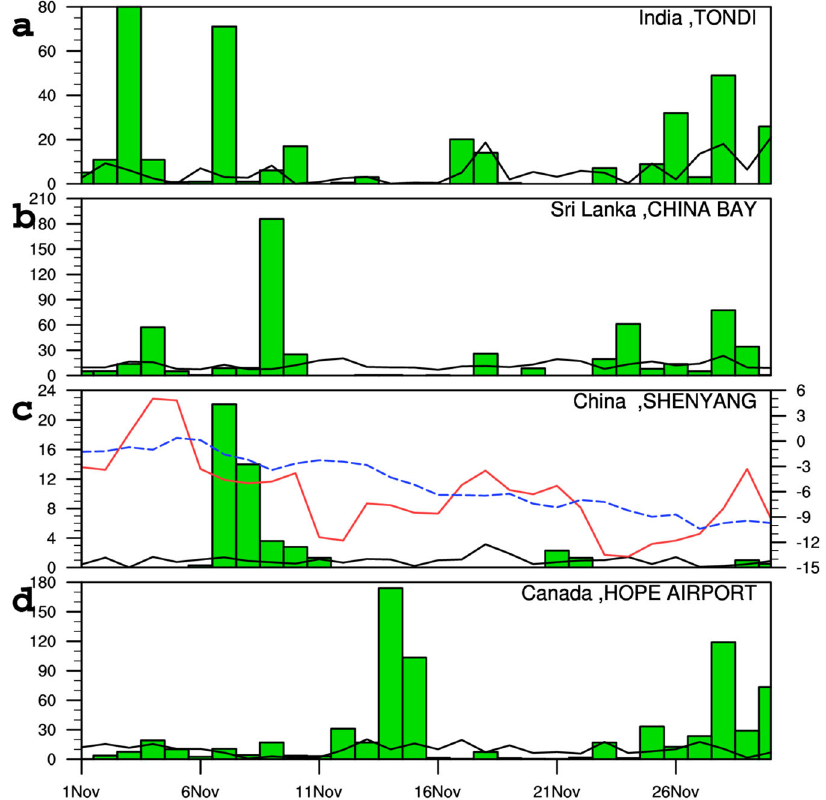
Fig. 1 Sequential extreme precipitation events from India to Canada during COP26 2021. Histograms show daily precipitation (mm) at a Tondi, Southern India (9.7°N, 79.0°E), b China Bay, Sri Lanka (8.5°N, 81.2°E), c Shenyang, northeast China (41.7°N, 123.5°E), and d Hope airport British Columbia, Canada (49.4°N, 121.5°W). The black curves denote climatology. The red curve in c represents the daily minimum temperature (°C), and the blue dashed curve is the corresponding